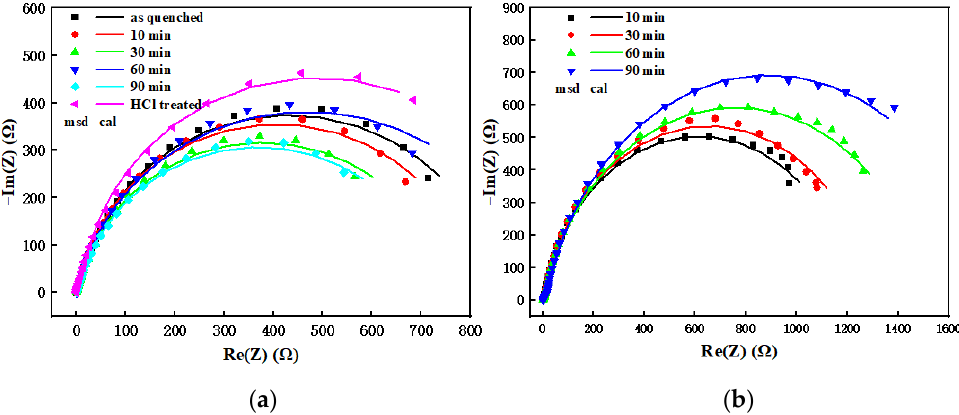
Figure 7. Impedance curve and equivalent circuit diagram of the sample ’ s heat treatment at 280 °C: ( a ) vacuum, ( b ) non-vacuum.